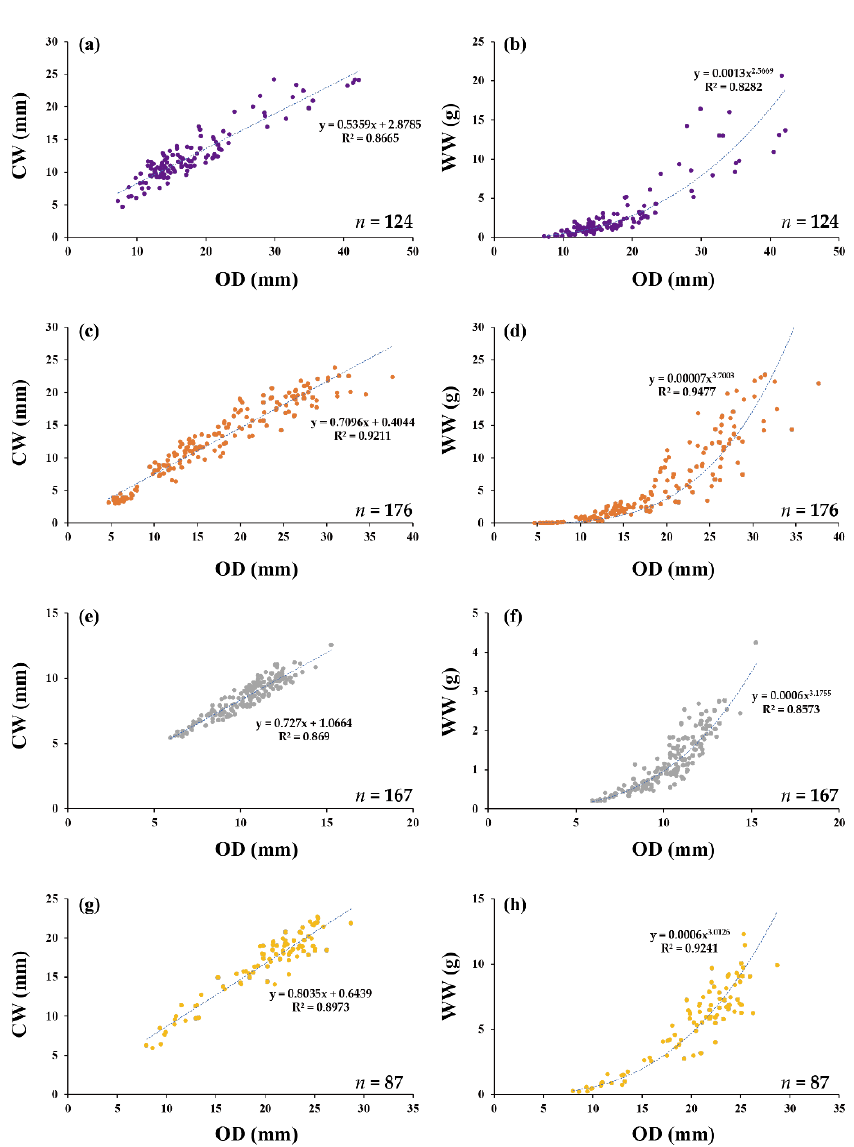
Figure 3. The relationship between ( a ) OD and CW for M. japonicus , ( b ) OD and WW for M. japonicus , ( c ) OD and CW for U. arcuata , ( d ) OD and WW for U. arcuata , ( e ) OD and CW for U. lactea lactea , ( f ) OD and WW for U. lactea lactea , ( g ) OD and CW for O. stimpsoni , and ( h ) OD and WW for O. stimpsoni . Table 2. Comparison of burrow opening diameters and morphometric data for each species (mean value ± standard deviation).